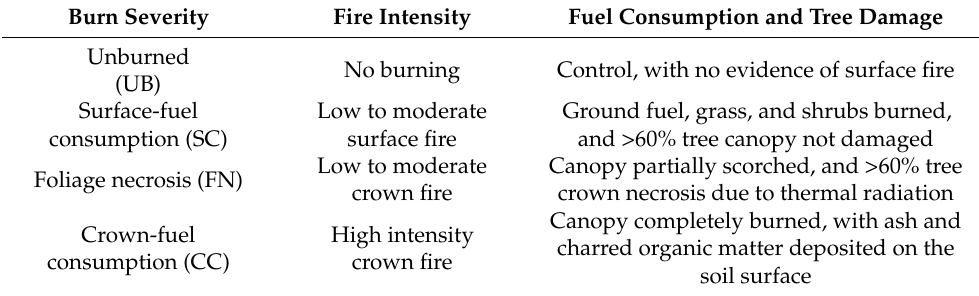
Table 1. Vegetation burn severity classification used in the study